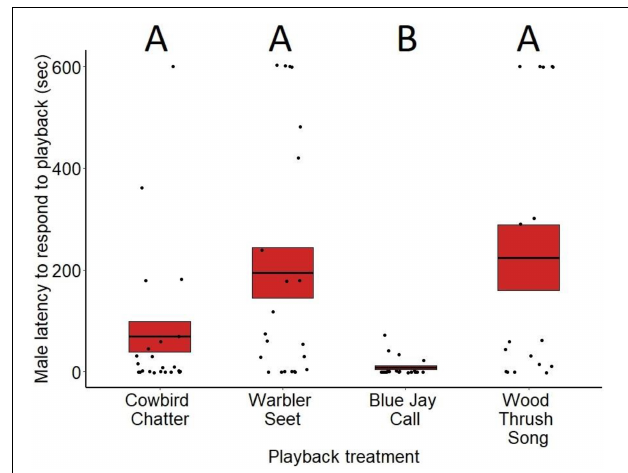
FIGURE 1 | Latency (in seconds) for male red-winged blackbirds to respond to the playback treatments at nests during nestling stage. Means are shown with the bold line, and shaded boxes represent standard errors. Boxes with different letters denote post hoc statistical differences between treatments. For the p -values of post hoc comparisons, please refer to Supplementary Table 1